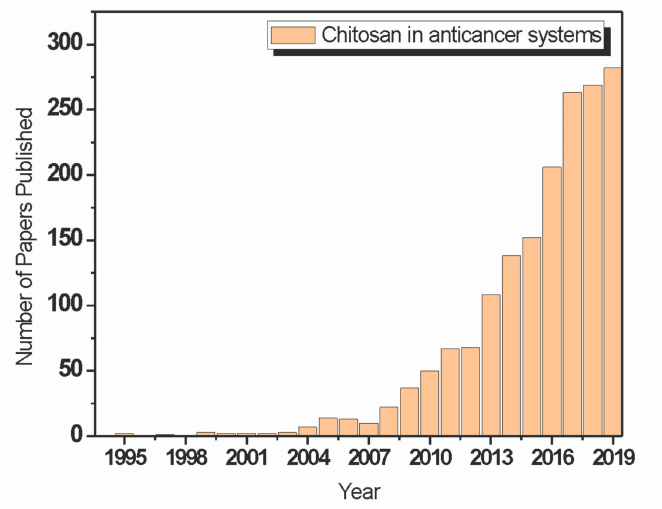
Figure 5. Literature data extracted from the Web of Science Core Collection about papers that address chitosan (CS) in anticancer